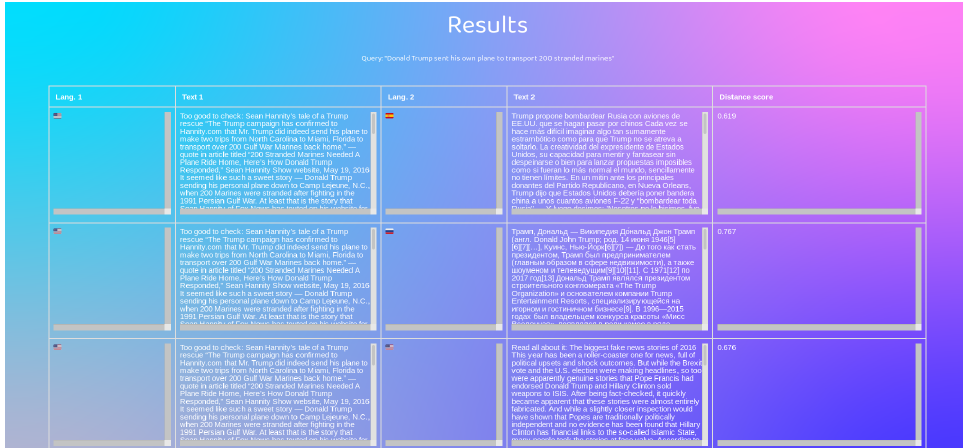
Figure A6. Comparison of cross-lingual news according to the user’s request: “Donald Trump sent his own plane to transport 200 stranded marines”